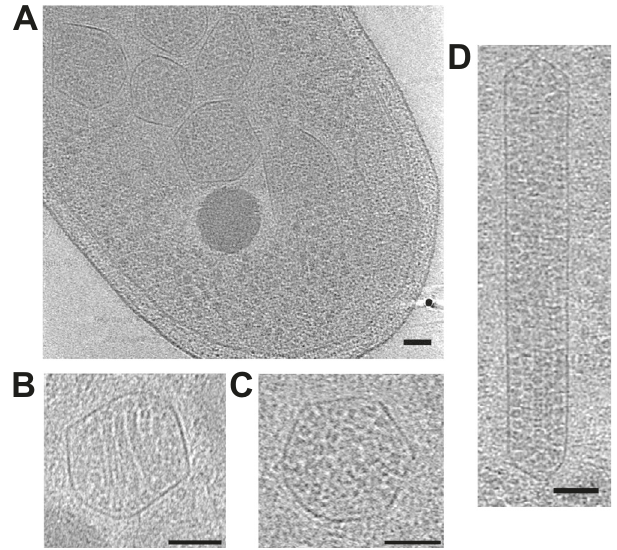
Fig. 6 | Carboxysomes inside H. neapolitanus cells. A An orthoslice through a tomogram of H. neapolitanus shows multiple carboxysomes packed inside the centerofthe cell.CBs are frequently in close proximity to phosphate granules and showgreaterheterogeneitycomparedtopuri fi edsamples. B AnorderedCBinvivo. C A dense CB in vivo. D Some CBs display anelongated morphology, with Rubisco alignedinrowswithorwithoutpolymerization.Allscalebars50nm;allorthoslices 5.4nm